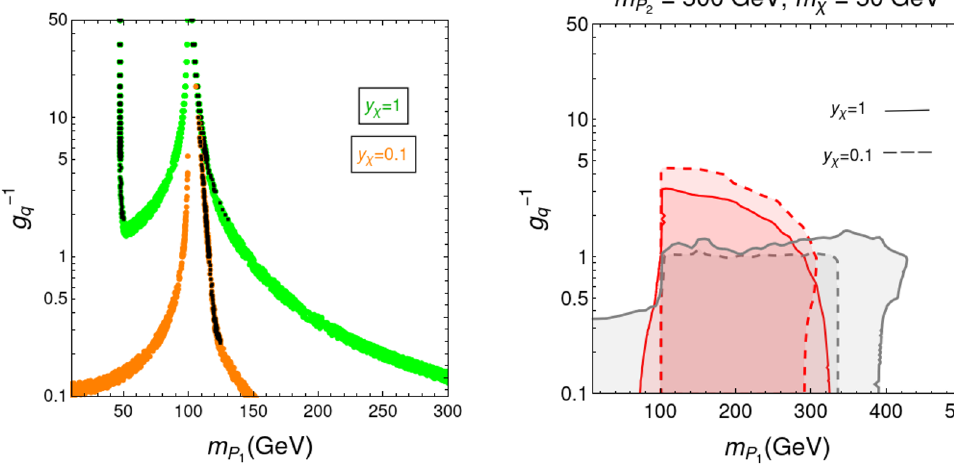
Figure 5 . Constraints on the model originating from the dark matter relic density and indirect detection bounds (left), as well as LHC constraints (right), for two representative values of y . The χ (cid:1) . The points that appear in light green (orange) are results are displayed in the plane (cid:0) m − 1 P 1 , g q associated with a relic density satisfying Ω h 2 = 0 . 12 ± 10% for y = 1(0 . 1) , whereas the darker χ points are additionally allowed by indirect detection bounds. The shaded regions in the right panel represent 95% confidence level exclusions from mono-jet (grey) and mono-Higgs (red) searches [80– 82]. The solid (dashed) lines corresponds to exclusions for y = 1 (0 . 1) χ